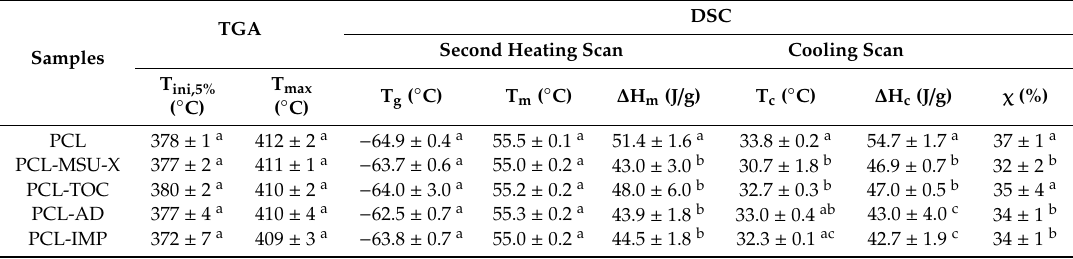
Table 2. Thermal parameters obtained by DSC and TGA (N 2 atmosphere) in PCL-based films.